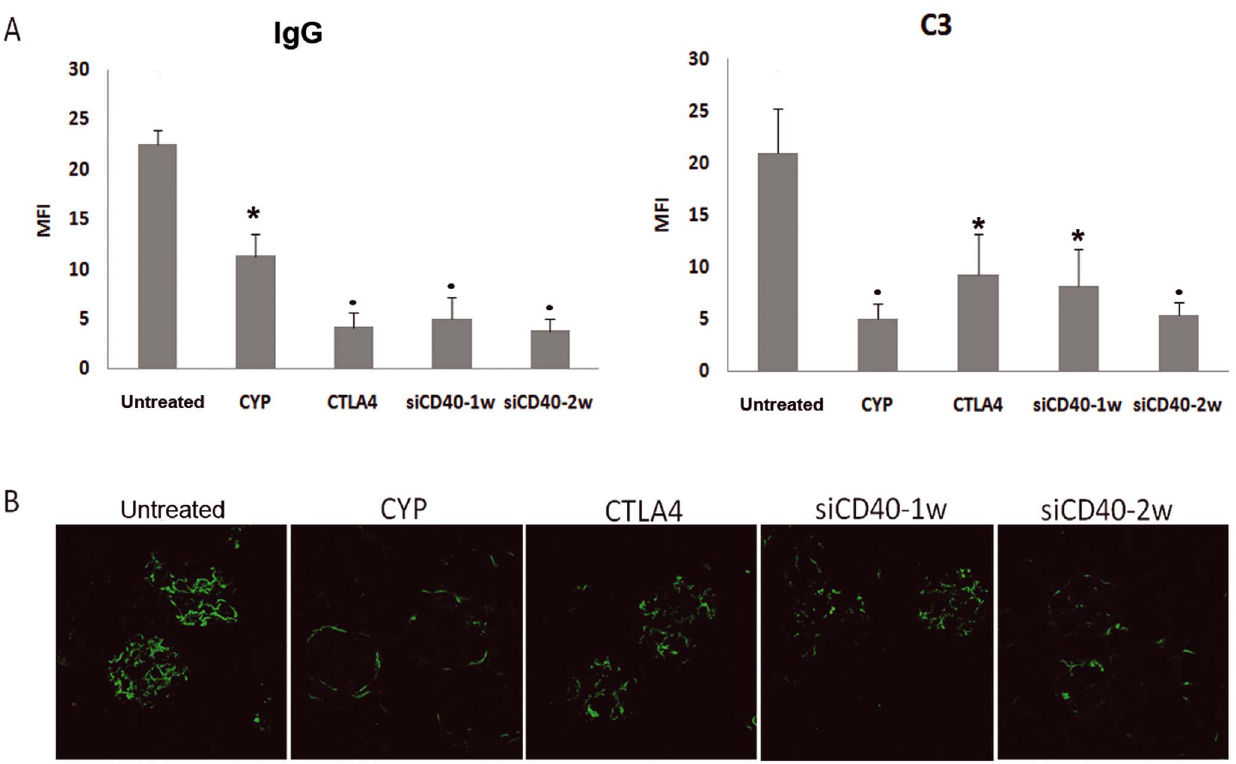
Figure 6. Immunohistochemical analysis for renal IgG and C3. A) Deposits of renal IgG and C3 were quantified with confocal microscopy (MFI). All treatments reduced glomerular deposits. B) Representative photomicrographs of C3 deposits (x630) for each group. Data are expressed as